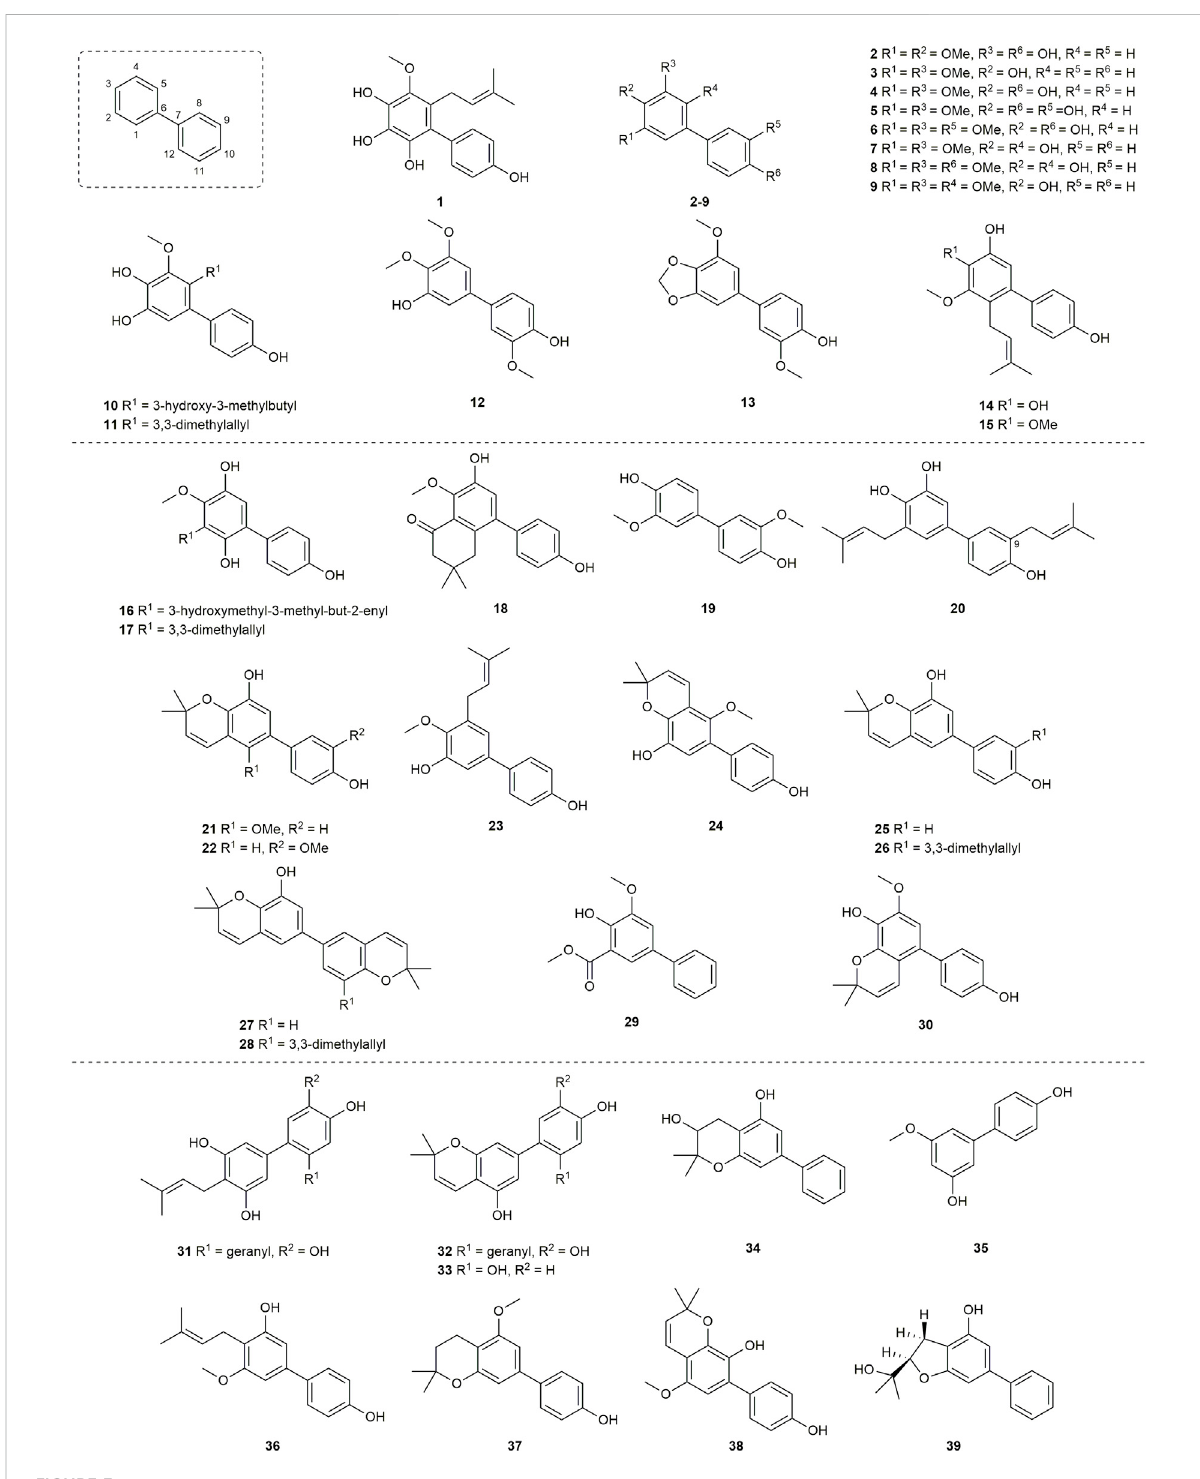
FIGURE 3 Structures of biphenyls 1 – 39